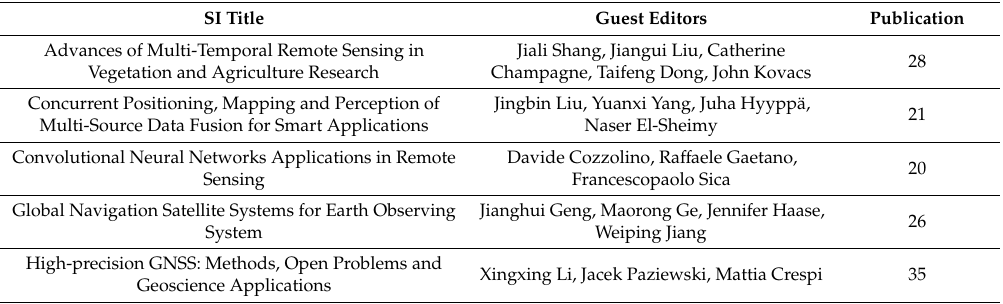
Table 2. The newly set up Special Issues (SIs) and the rate of publications for SIs in the past three years.